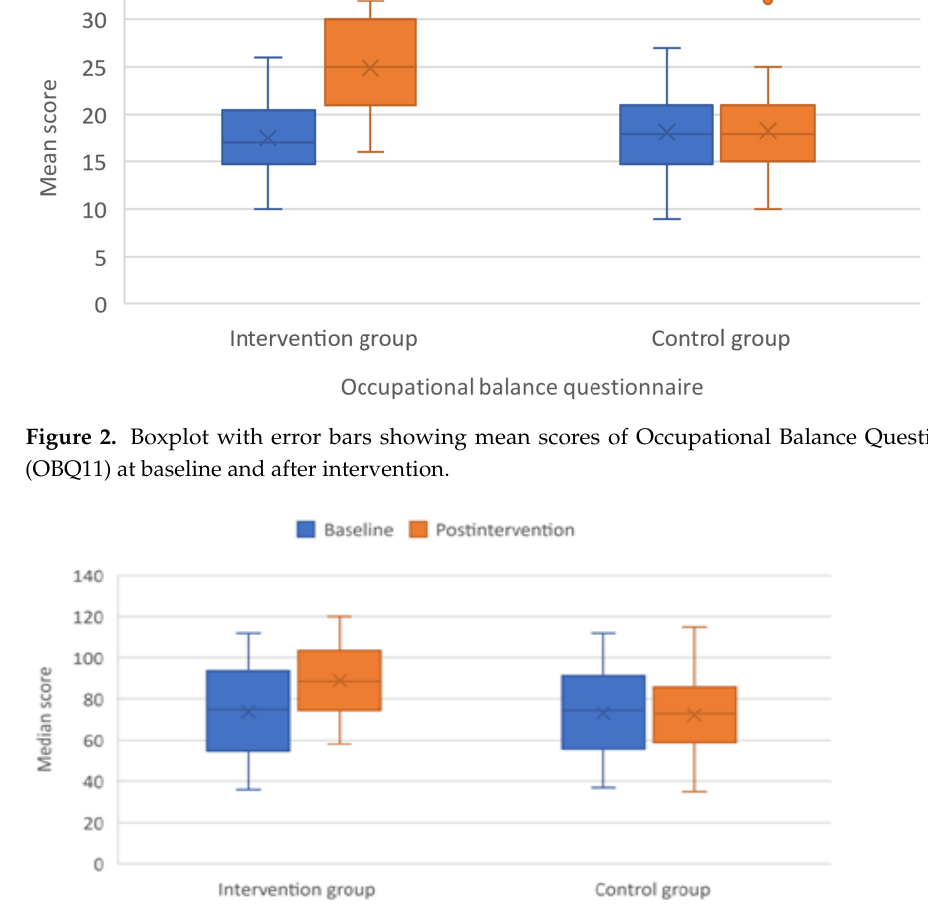
Figure 3. Boxplot graph depicting median scores of Well-Star scale (WSS) at baseline and after in- tervention. Children who underwent online training experienced a significant increase in their intrinsic motivation. The IMS score increased by a median of 17 points in the intervention group, whereas it decreased by a median of 2.5 points in the children who served as the control group ( p < 0.001) (Figure 4).